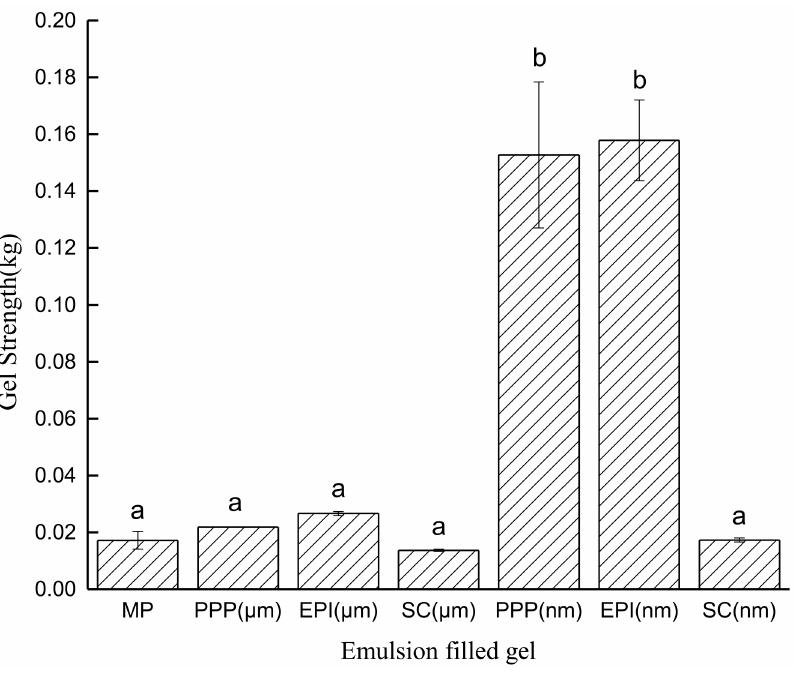
Figure 5. Gel strength of heat-induced MP-emulsified soybean oil composite gels. Gels were prepared from MP mixed with macro-emulsion and nano-emulsion of PPP, EPI, SC, and macro-emulsion of MP. PPP: porcine plasma protein; EPI: egg-white protein isolate; SC: sodium caseinate; MP: myofibrillar protein. Different letters in the same column means significant difference ( p < 0.05), n =